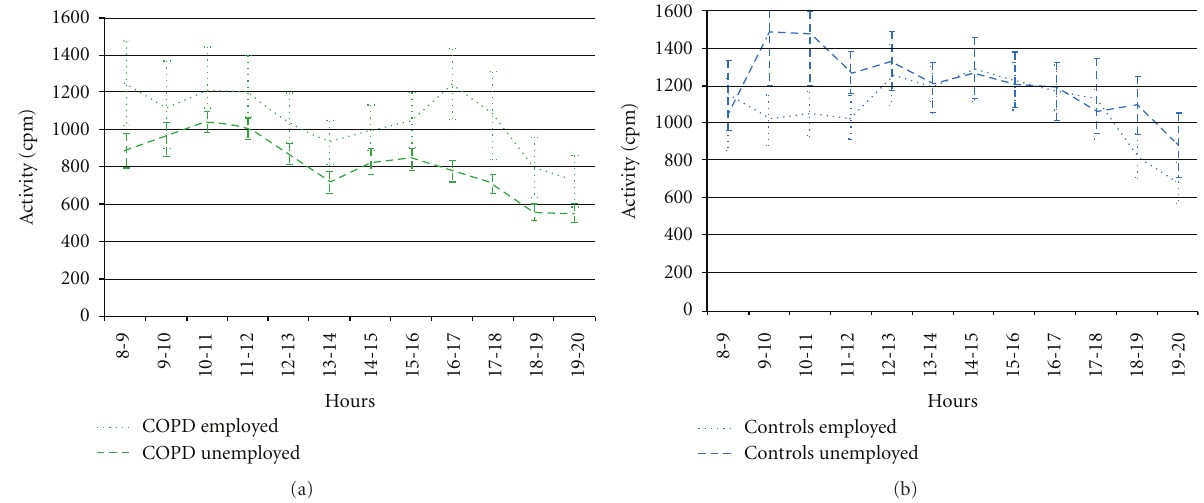
Figure 2: The daily activity pattern in mean activity per hour (cpm) for both the COPD group and the healthy control group with standard errors of the means.